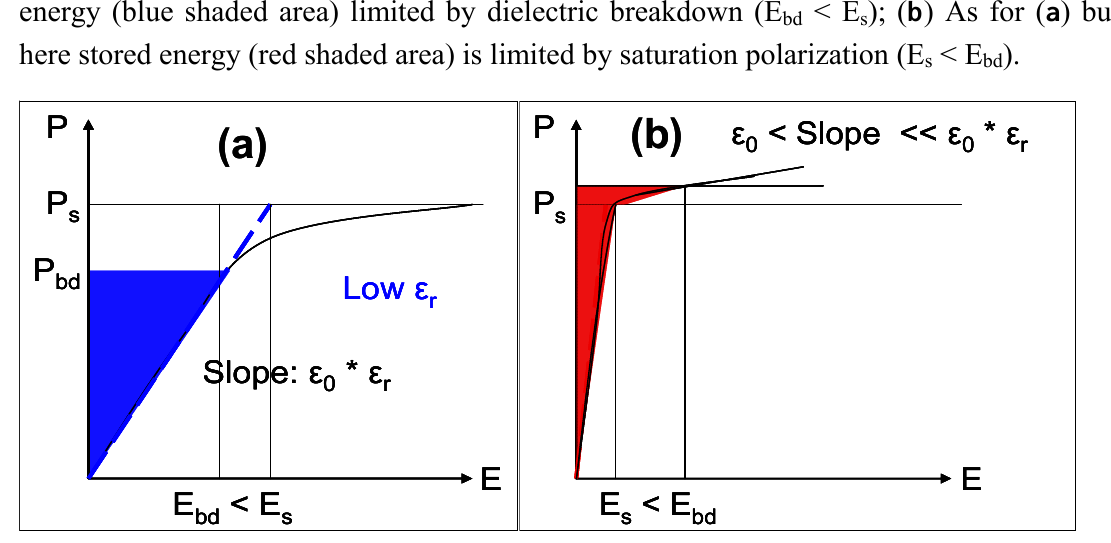
Figure 8. ( a ) Schematic of polarization vs . electric field strength for case where stored energy (blue shaded area) limited by dielectric breakdown (E here stored energy (red shaded area) is limited by saturation polarization (E